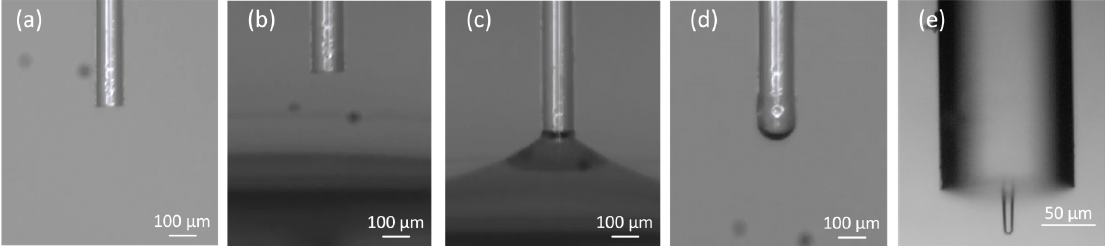
Figure 2. Fabrication process stages of the polymeric spherical tips on top of optical fibers used in this study ( a – e